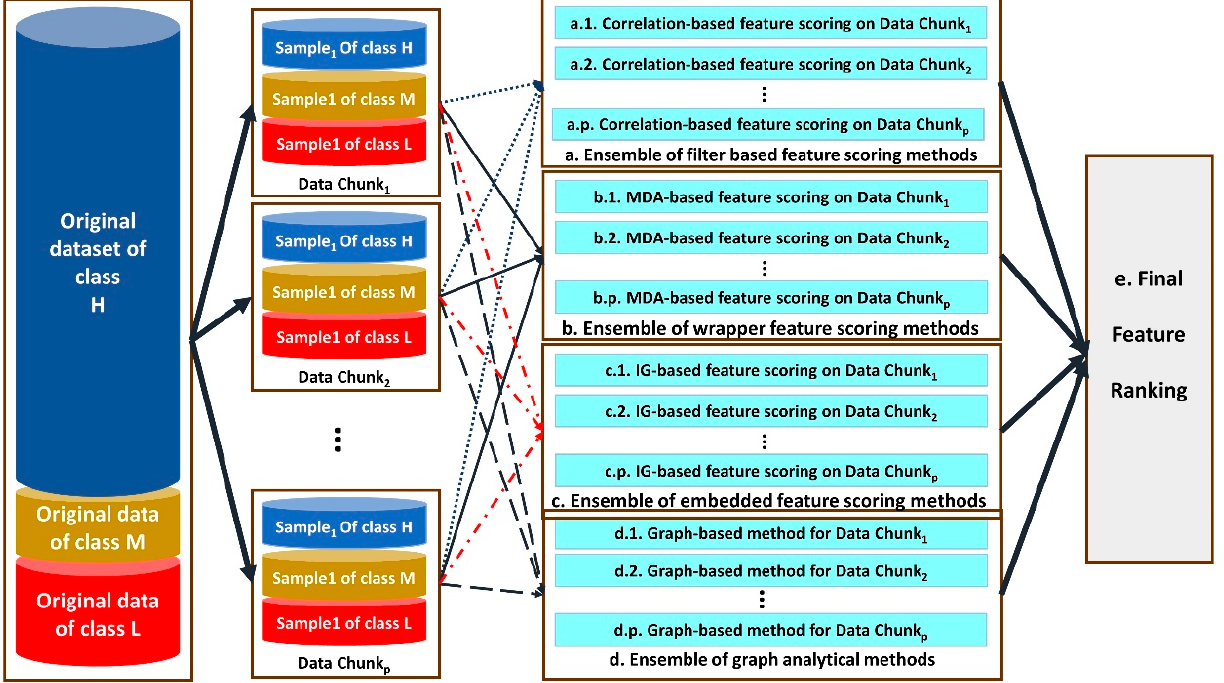
Figure 2. The architecture of our proposed distributed multi-level ensemble feature ranking